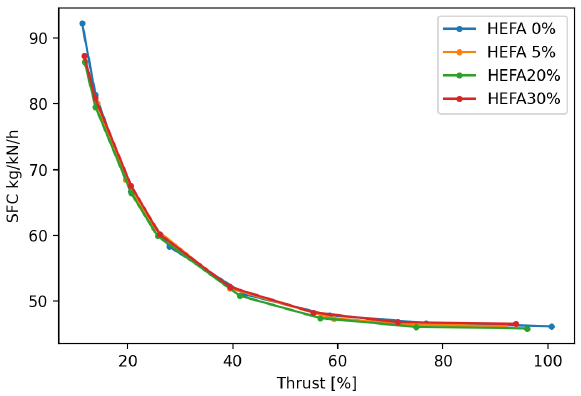
Figure 26. DGEN 380/HEFA: SFC.